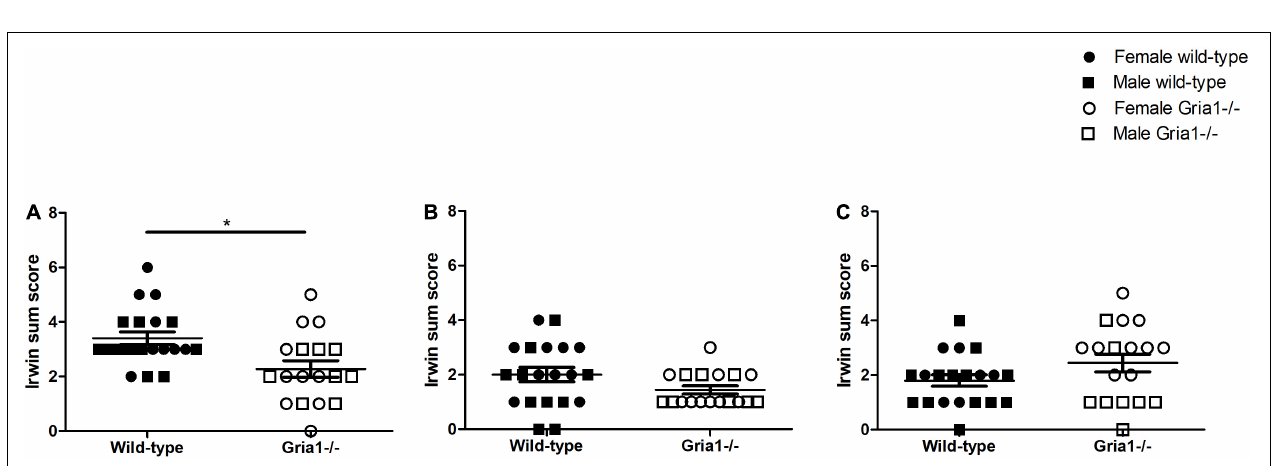
FIGURE 9 | Irwin Score. The assessment of Irwin sum scores, calculated by adding up the score from all single parameters, revealed a significant group difference in prepubescent mice (A) with wild-type mice reaching higher sum scores than Gria1 − / − mice. In pubescent mice (B) and sexually mature mice (C) , significant group differences were absent. ANOVA, followed by FDR correction or Bonferroni multiple comparison post hoc tests. n = 8–10 per genotype per sex. * p < 0.05. Error bars indicate the standard error of the mean (SEM). * p < 0.05. Error bars indicate the standard error of the mean (SEM).